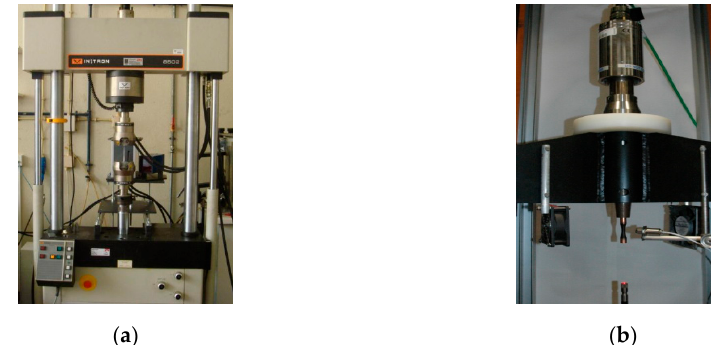
Figure 1. Fatigue testing in ( a ) a servo-hydraulic ‘conventional’ machine; and ( b ) an UFT machine.